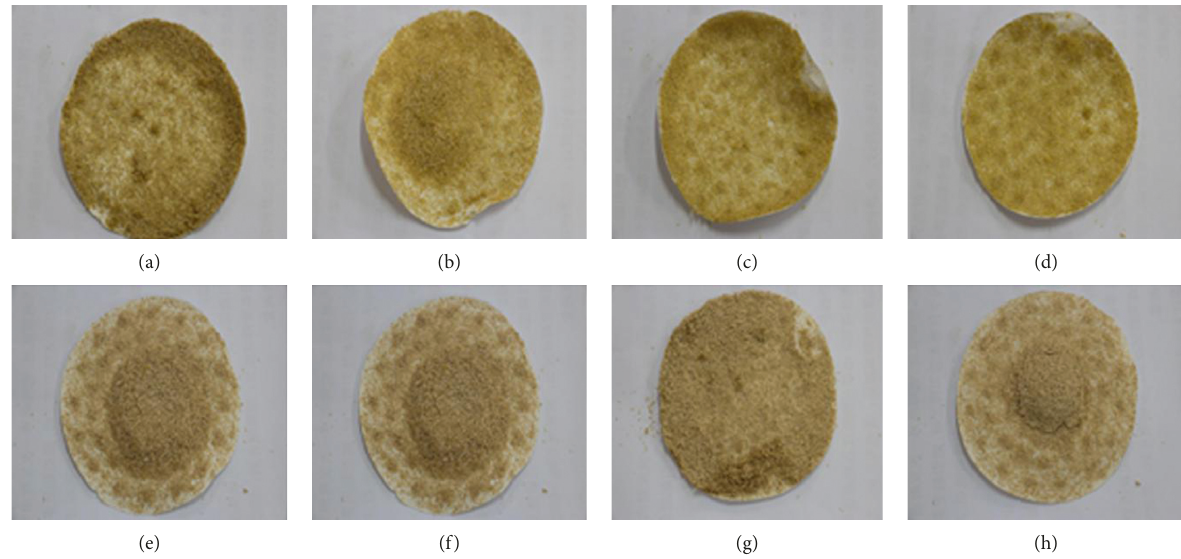
Figure 1: The hue changes of rice stem before and after modification by the modified materials: (a) 0.25mol/L NaOH; (b) 0.5mol/L NaOH;